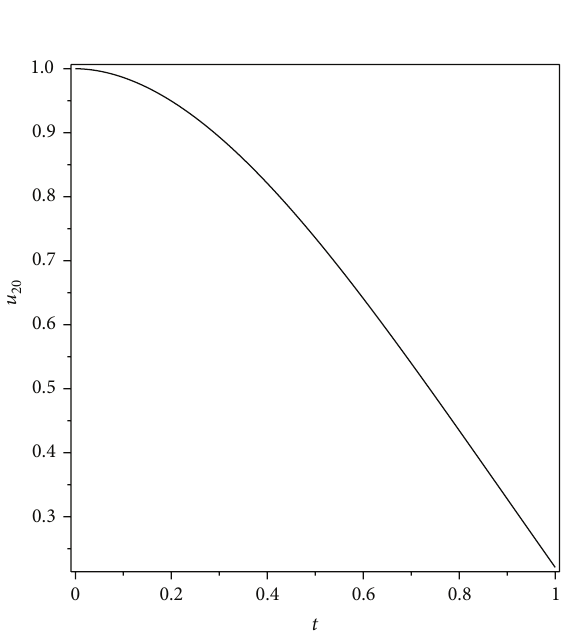
Figure 2: Approximate solution of (11).